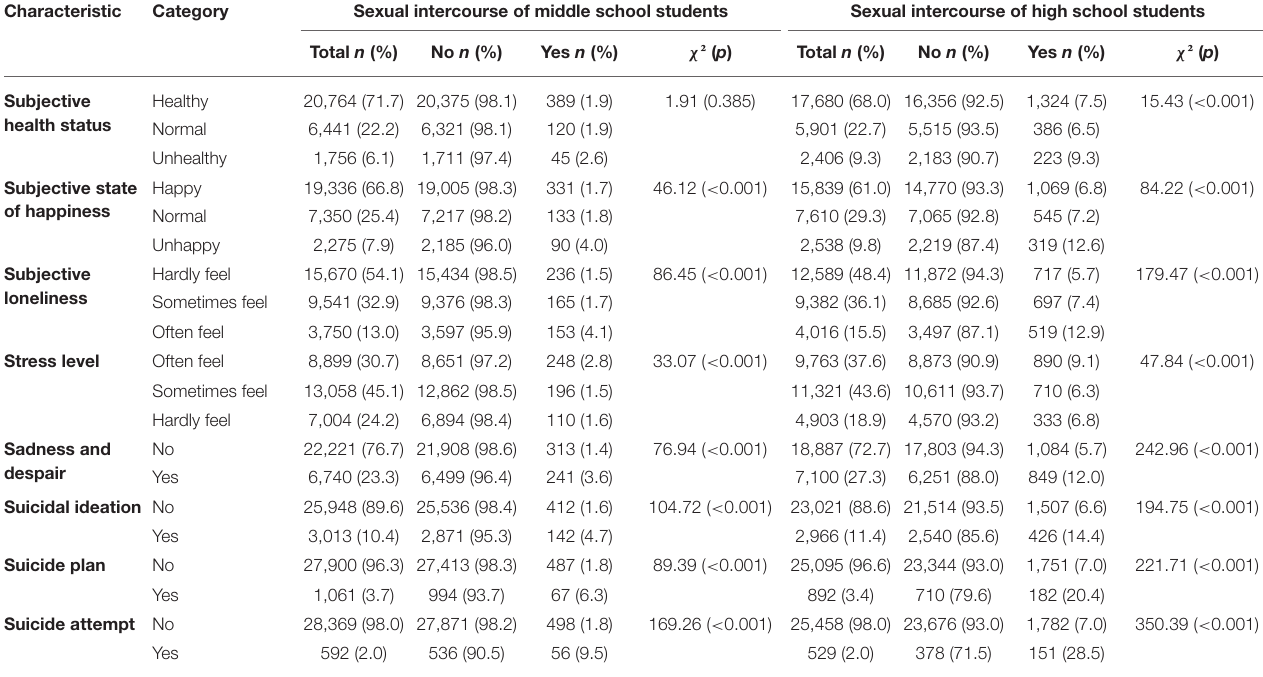
TABLE 3 | Mental health characteristics of the participants ( n = 54,948).